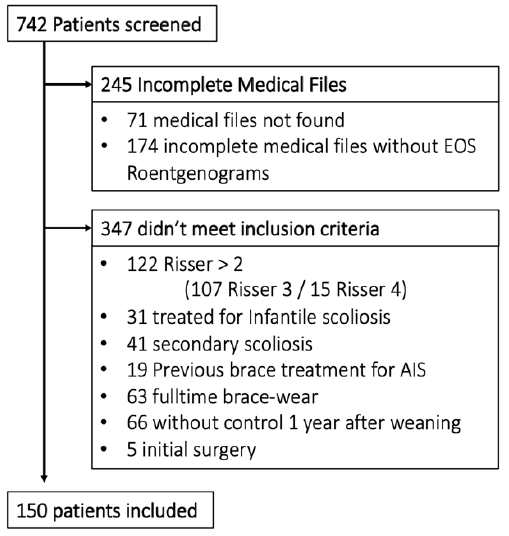
Figure 2. Flowchart.